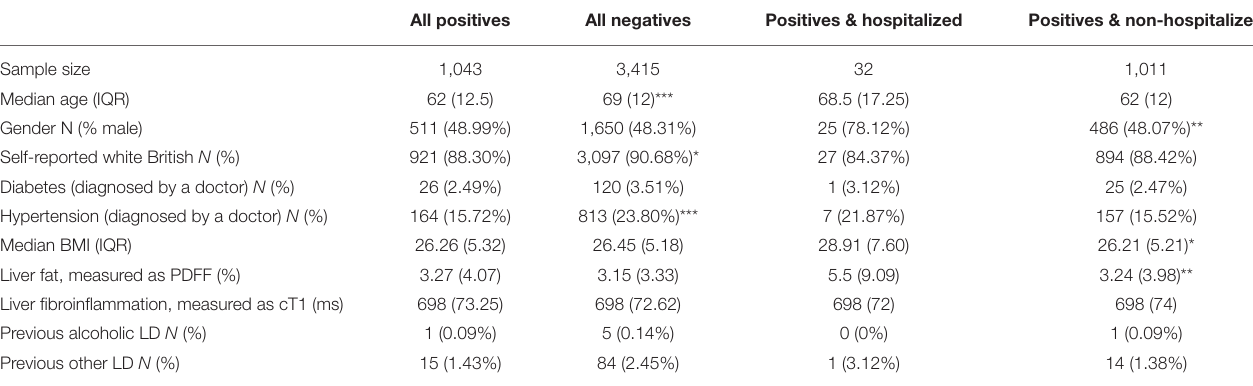
TABLE 1 | Participant characteristics – data reported as median [interquartile range] or n (%). Significance assessments of the negative test group vs. the positive test group, and the positive hospitalized group vs. the positive non-hospitalized group.